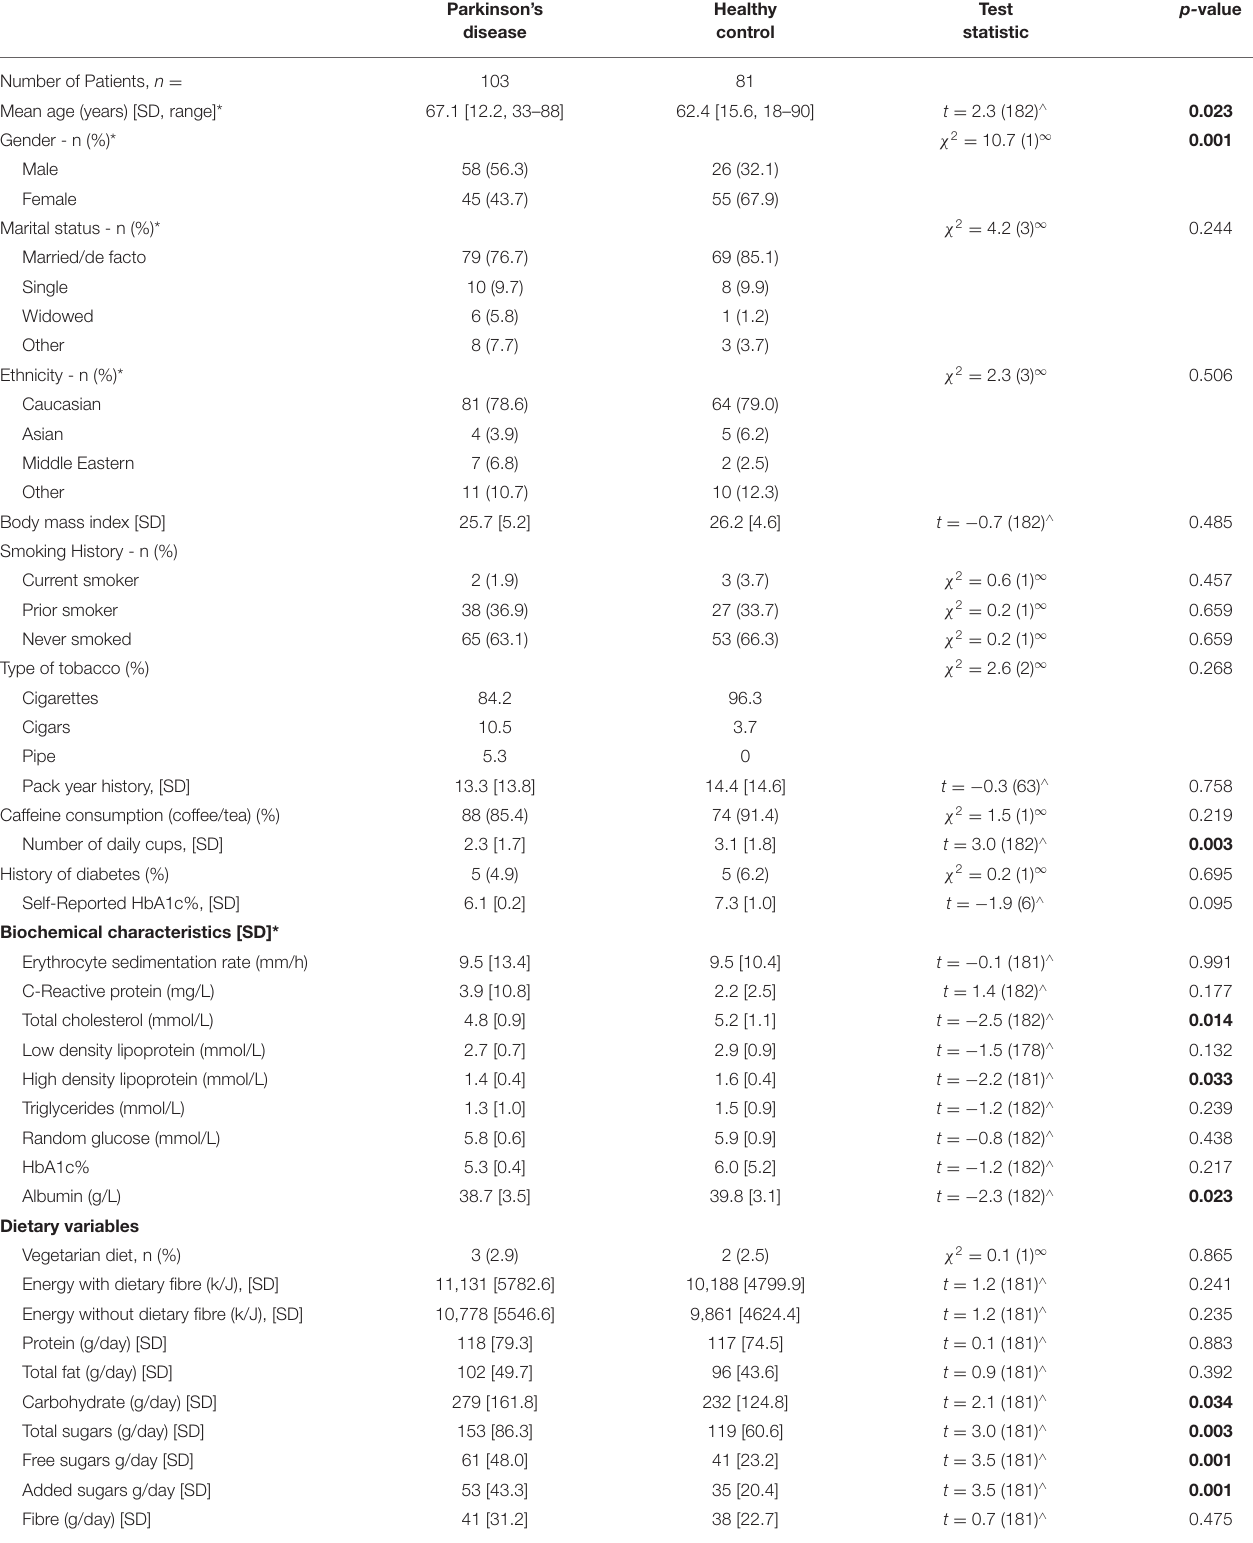
TABLE 1 | Cohort demographic and clinical characteristics.